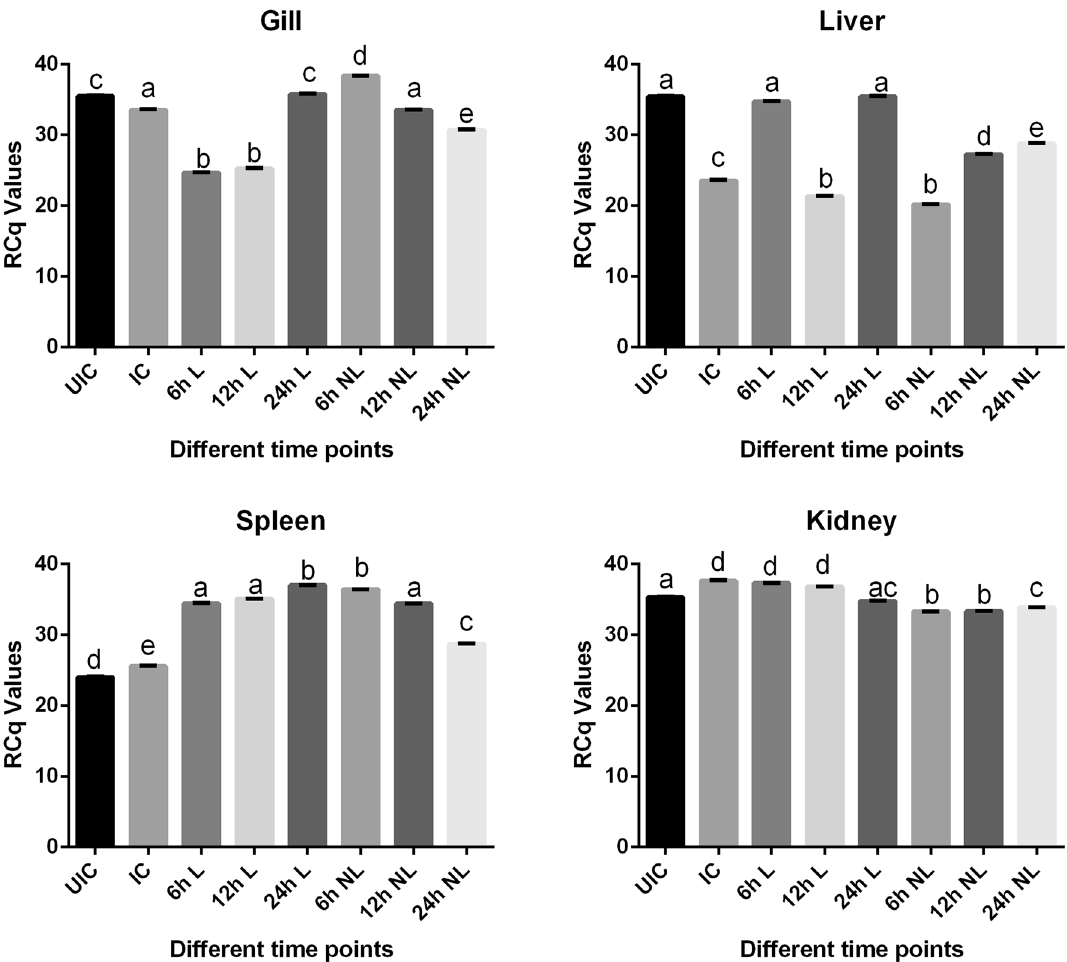
Figure 6. Gene expression analysis of MyD88 in the gills, liver, kidney and spleen of infected fish with A. hydrophila and treated with lectin and Pt-lec at different time intervals (6 h, 12 h and 24 h). UIC Uninfected control, IC infected control, L lectin treated, NL lectin-PtNPs hybrid